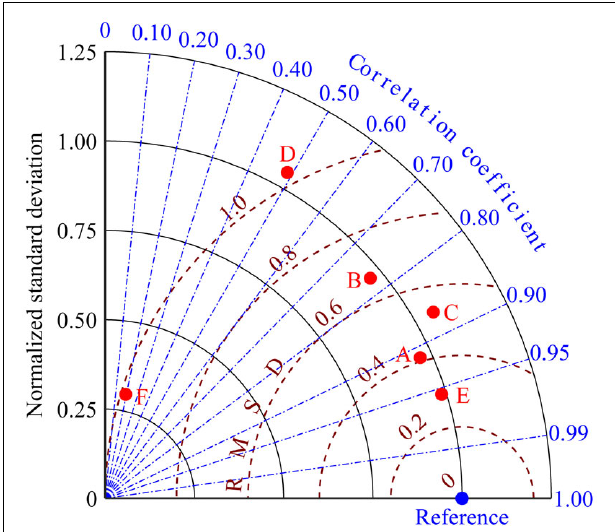
FIGURE 10 | Taylor diagram comparing the temperature when the bottom-water temperature was less than 0 ◦ C in winter (RGDW) (blue dot) and when the bottom-water temperatures were less than 0 ◦ C on February 1 (RAW) (red dot A); when the bottom-water temperature was greater than 20 ◦ C in summer (RGDS) (blue dot) and when bottom-water temperatures of more than 20 ◦ C on September 1 (RAS) (red dot B), restricted growth days (RGD) (blue dot) and RAW (red dot C), RGD (blue dot) and RAS (red dot D), RGD (blue dot) and RGDW (red dot E), and RGD (blue dot) and RGDS (red dot F), respectively, for the Yesso scallop ( P. yessoensis ) in the Changhai sea area,